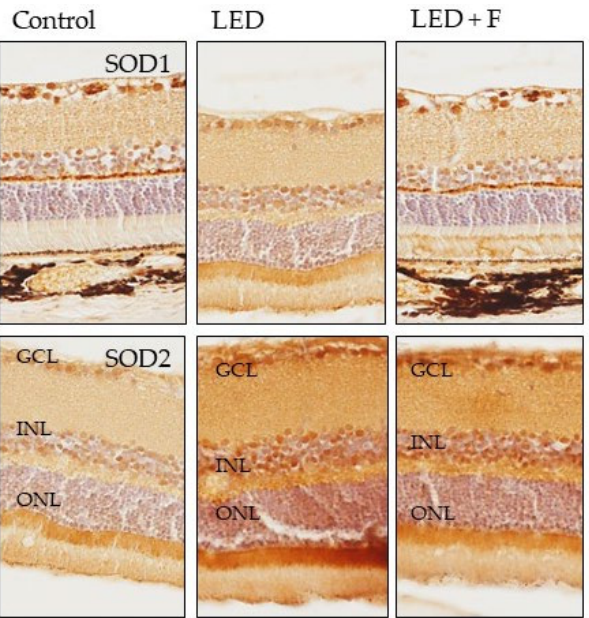
Figure 10. Immunohistochemical detection of SOD1 ( upper panel ), and SOD2 ( lower panel ) in the three groups of rats investigated. LED: animals exposed to LED-backlit screen for 3 months; LED + F: animals exposed to filtered LED-backlit screen for 3 months. GCL: ganglionic cells layer; INL: inner nuclear layer; ONL: outer nuclear layer.